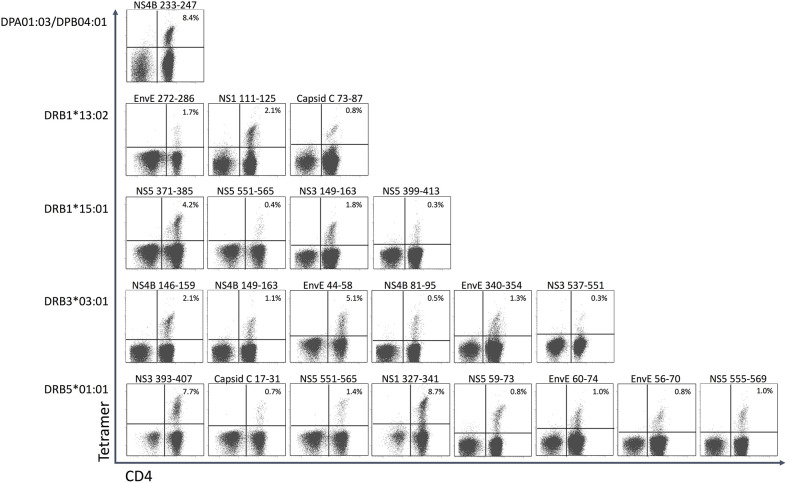
CD4+ T cell epitopes in donor YF1067. PBMC's from donor YF-1067 were expanded using the stimulatory 15mer peptides identified. For each peptide, a biochemical HLA class II binding assay was used to identify which of donor YF1067's HLA-II molecules could bind the peptide and therefore could serve as restriction elements. Productively interacting peptide-HLA-II combinations were used to design and generate peptide-HLA class II tetramers. The resulting tetramers were used to stain and analyze expanded CD4+ T cells by flow cytometry gating on CD3+ T cells. Note, that the selective HLA class II tetramer staining of CD4+, not CD8+, T cells is a demonstration of the specificity of the tetramer staining. The identities of the epitopes and their restricting HLA-II elements are indicated.